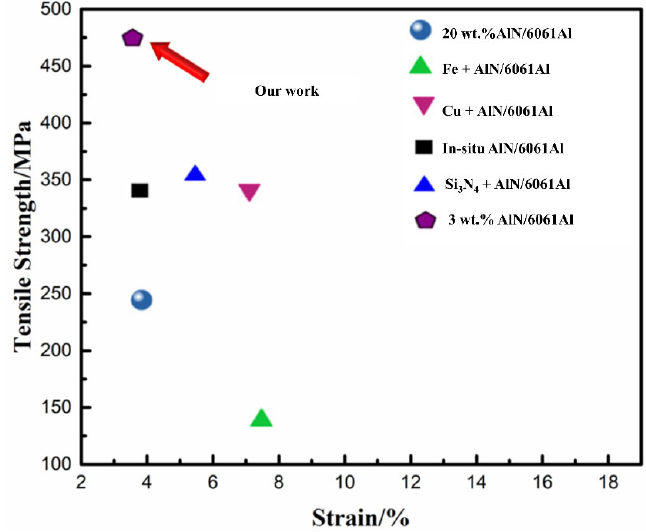
Figure 13. Comparison of the yield strength of nano ‐ AlN/AA6061 composites in literature[49–52].